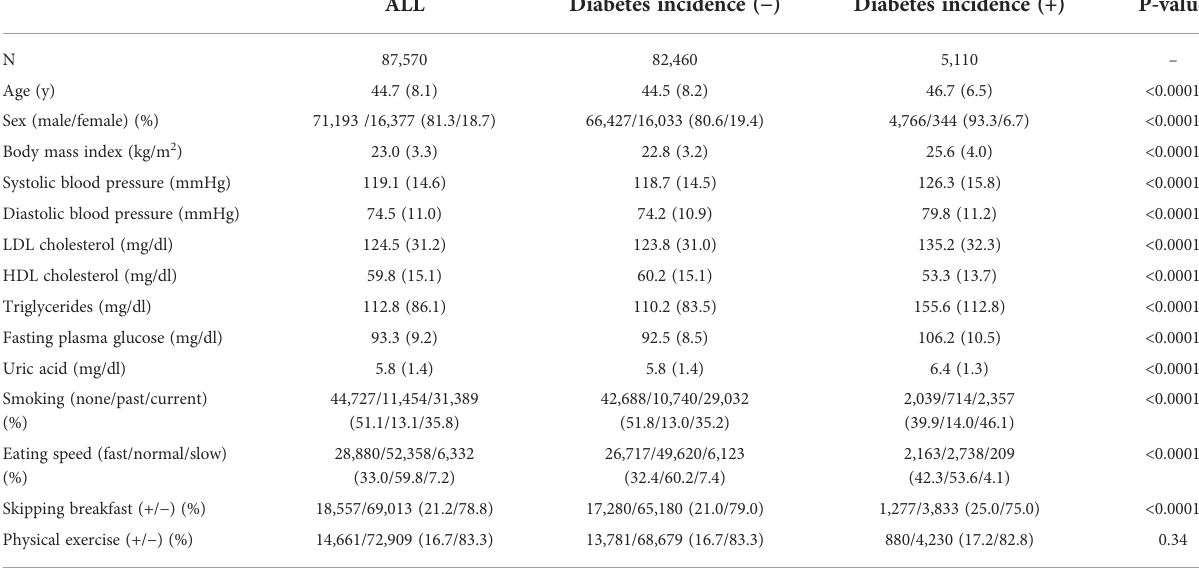
TABLE 1 Characteristics of Panasonic Cohort Study participants at baseline by diabetes incidence during the 10-year follow-up period.